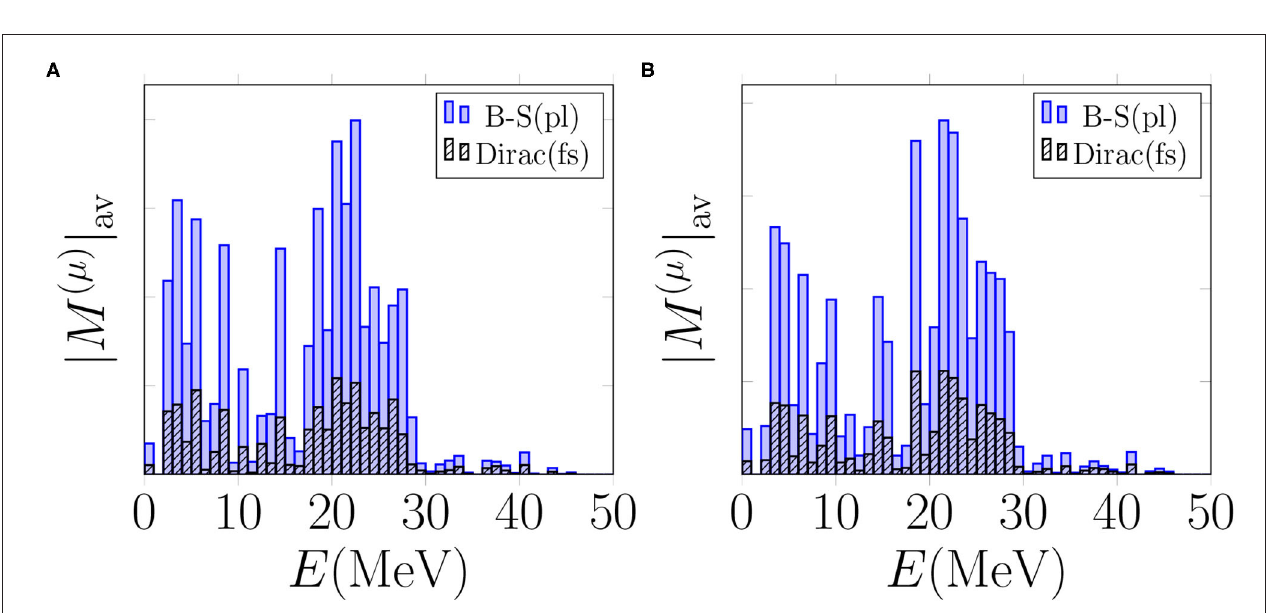
FIGURE 10 | Average OMC matrix elements for the captures to J π = 2 + states computed with different bound-muon wave functions. “B-S(pl)” denotes the Bethe-Salpeter point-like-nucleus approximation and “Dirac(fs)” the exact wave function solved from the Dirac equation taking into account the finite size of the nucleus. The value g ( T = 0) pp = 0.7 is adopted for particle-particle interaction parameter. (A) Basis: “Adj.”. (B) Basis: “WS”.